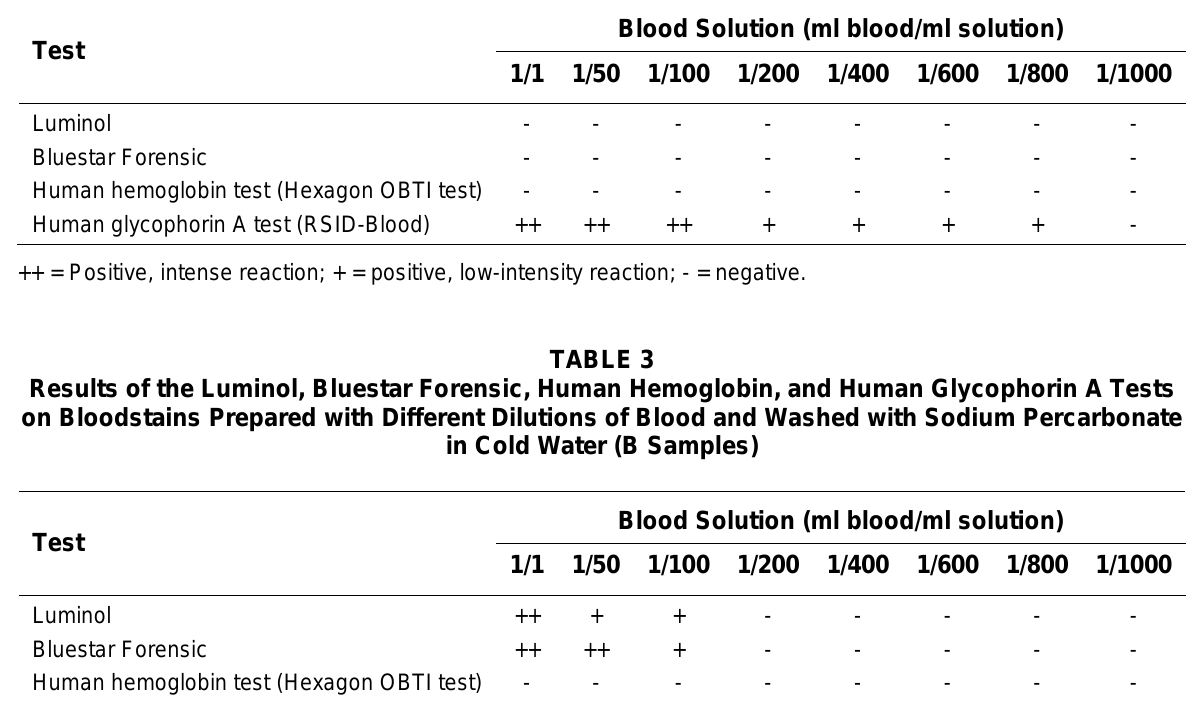
Results of the Luminol, Bluestar Forensic, Human Hemoglobin, and Human Glycophorin A Tests on Bloodstains Prepared with Different Dilutions of Blood and Washed with Sodium Percarbonate